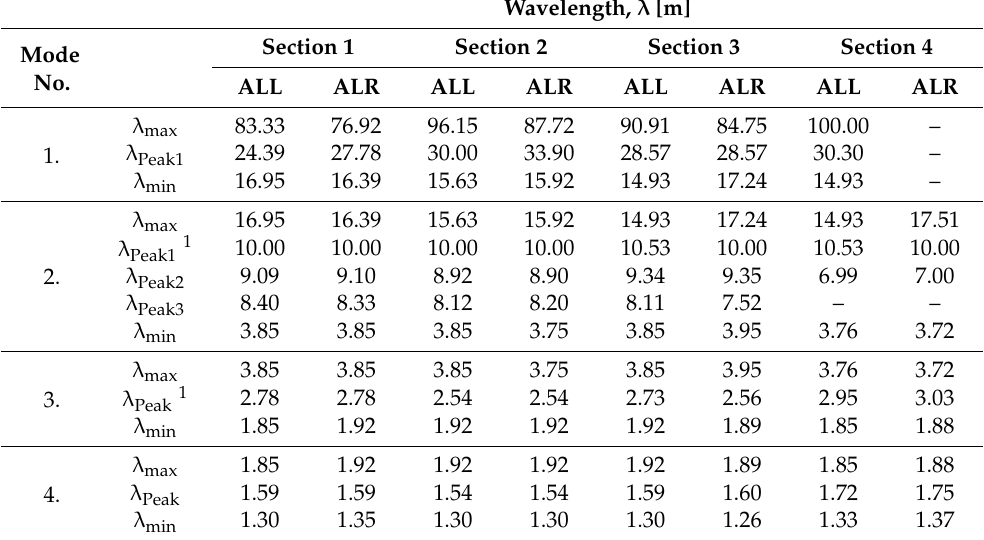
Table 6. The identified Modes (wavelength ranges) of ALL and ALR based on their smoothed FAS.